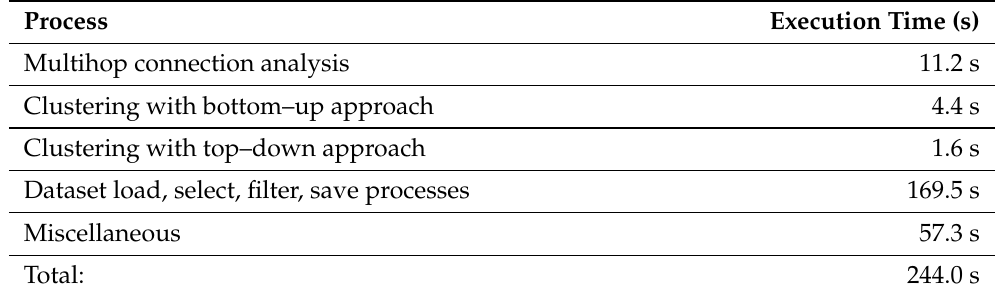
Table 9. Processing time (execution profile analysis) for a special experiment using 2375 smart